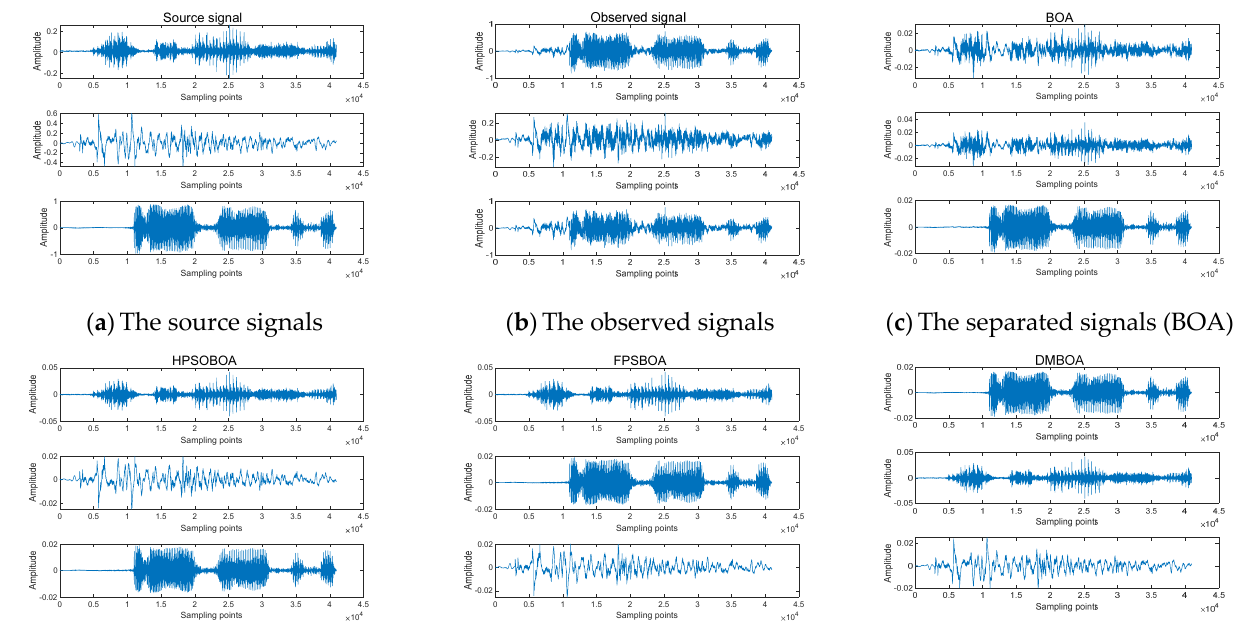
Figure 5. Effect drawing of speech signal separation. ( a ) The waveform of source signals; ( b ) the waveform of observed signals; ( c ) the waveform of BOA separation signals; ( d ) the waveform of HPSOBOA separation signals; ( e ) the waveform of FPSBOA separation signals; ( f ) the waveform of DMBOA separation signals. The PESQ metric is based on the wide ‐ band version recommended in ITU ‐ T [37], and